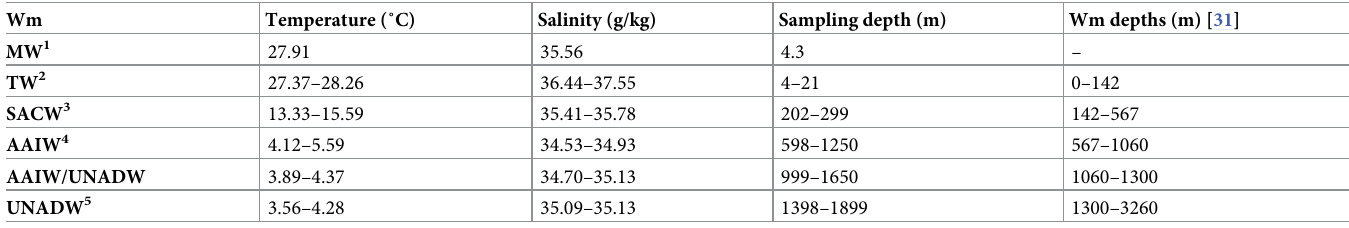
Table 2. Fieldwork recognition of the water masses (Wm). Thermohaline limits, sampling depths, and referential depths